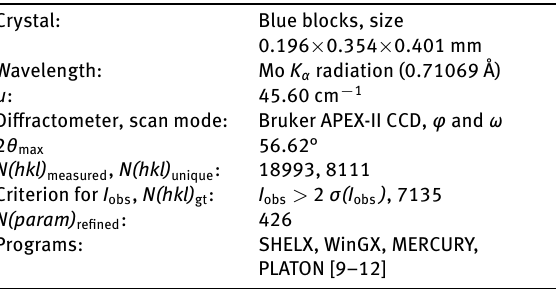
Table 1: Data collection and handling.